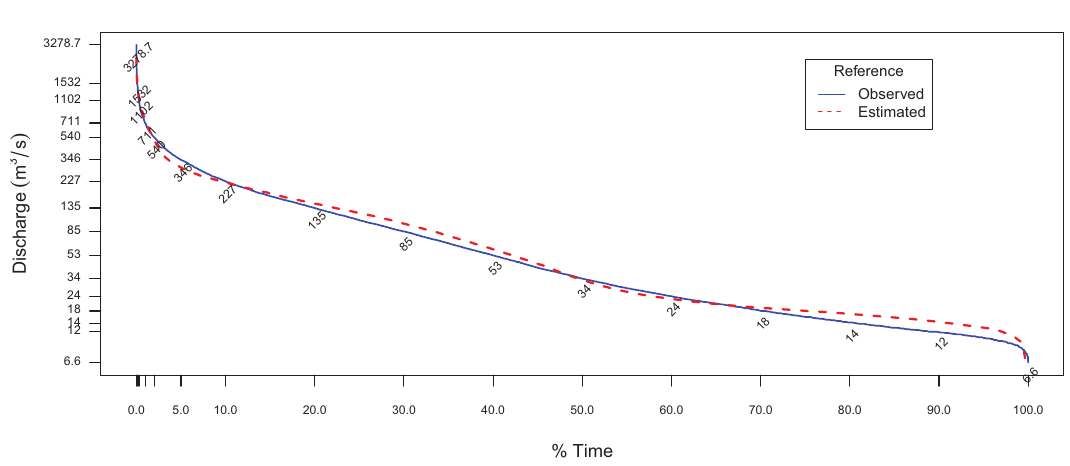
Figure 19. Duration Curve from validation data series 6.2CV of Balapuca, Bermejo river,